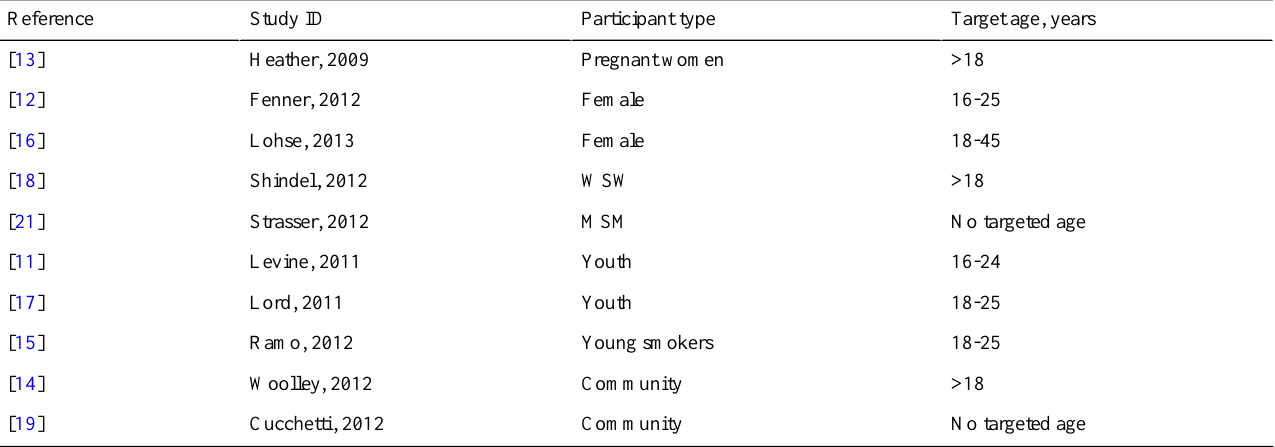
Table 4. Types of participants targeted by